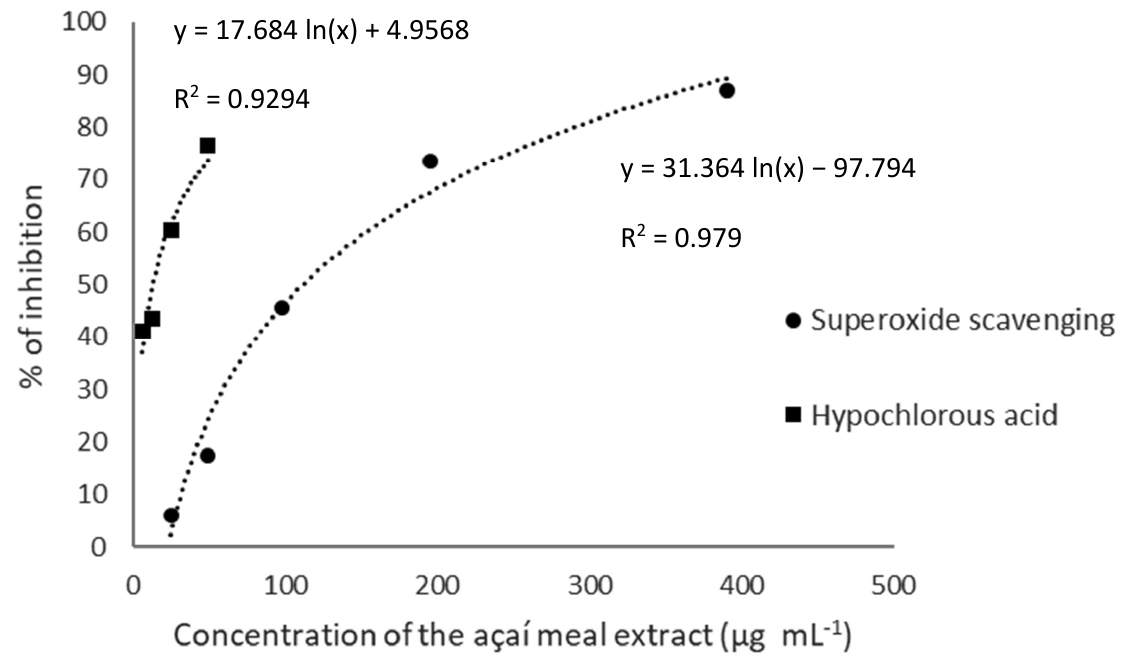
Figure 3. EC 50 graphics showing the scavenging of superoxide and hypochlorous acid of the optimized açaí meal extract. The figure indicates the scavenging percentage (%) as a function of the extract concentration (µg ∙ mL − 1 ).